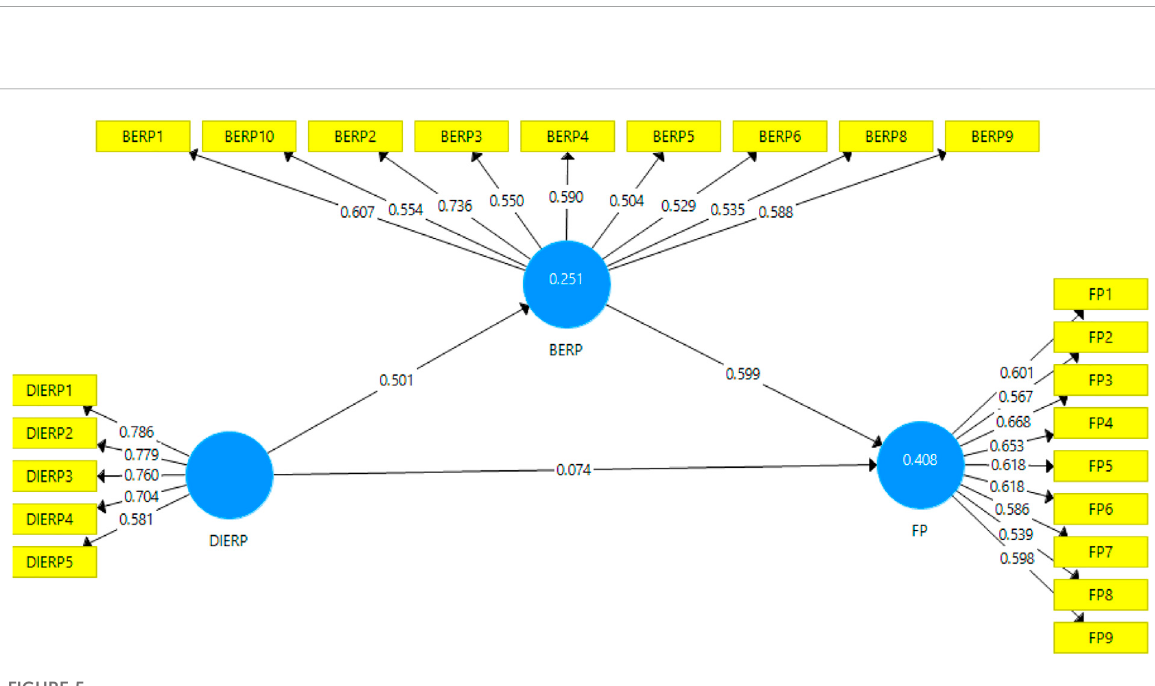
FIGURE 5 Mediating role of BERP in the relationship between DIERP and FP: A subsample of service and non-manufacturing sector fi